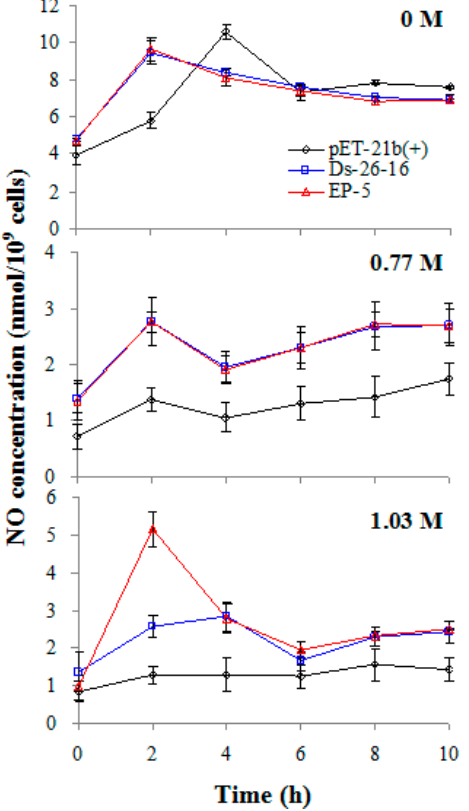
Figure 5. Nitric oxide content of E . coli transformants expressing Ds-26-16 or EP-5 under different NaCl stress. Nitric oxide was determined after pET-21b(+), Ds-26-16 and EP-5 were cultured under NaCl stress at different times.